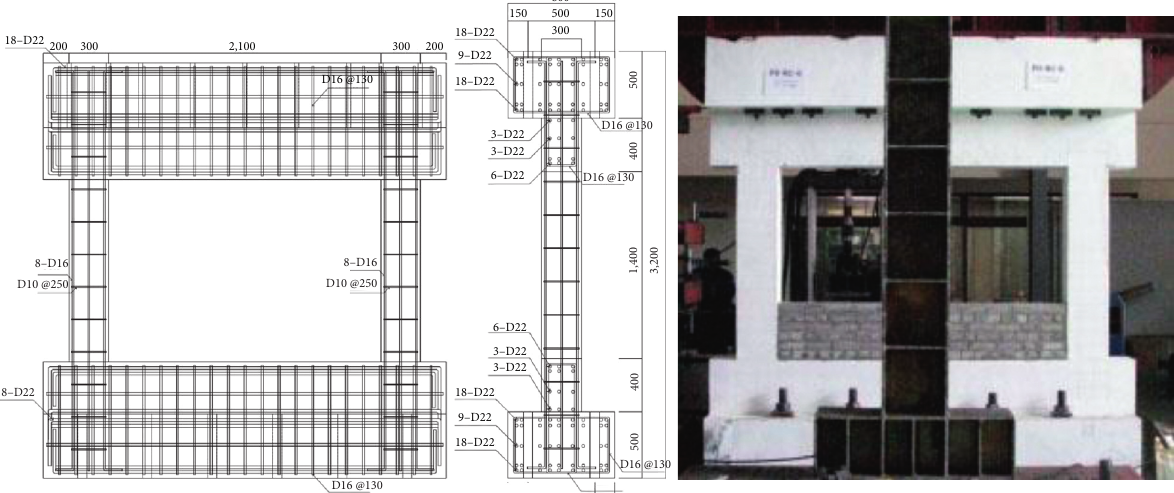
Figure 6: Detailed configuration of the control